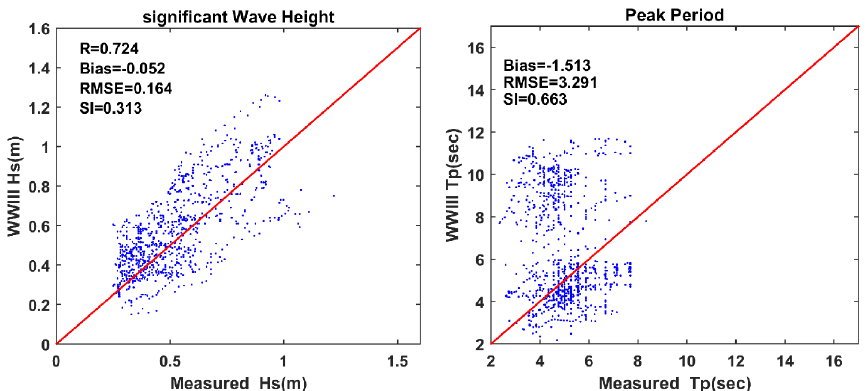
Figure 15. Evaluation of boundary condition wave height and peak wave period at NDBC 42001 just south of the model southern boundary.